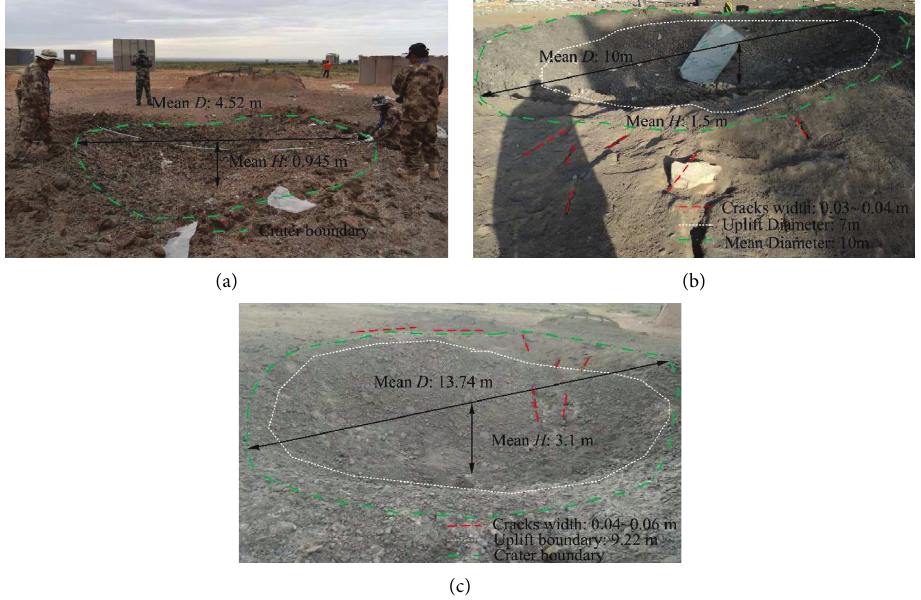
Figure 4: Craters generated by ground explosions of (a) 1 ton, (b) 3 tons, and (c) 10 tons of